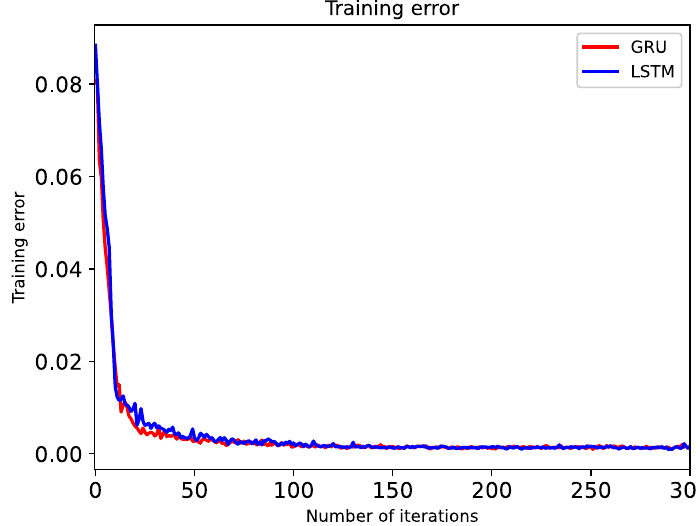
Figure 15. Plot of comparison of iterative convergence of two models.